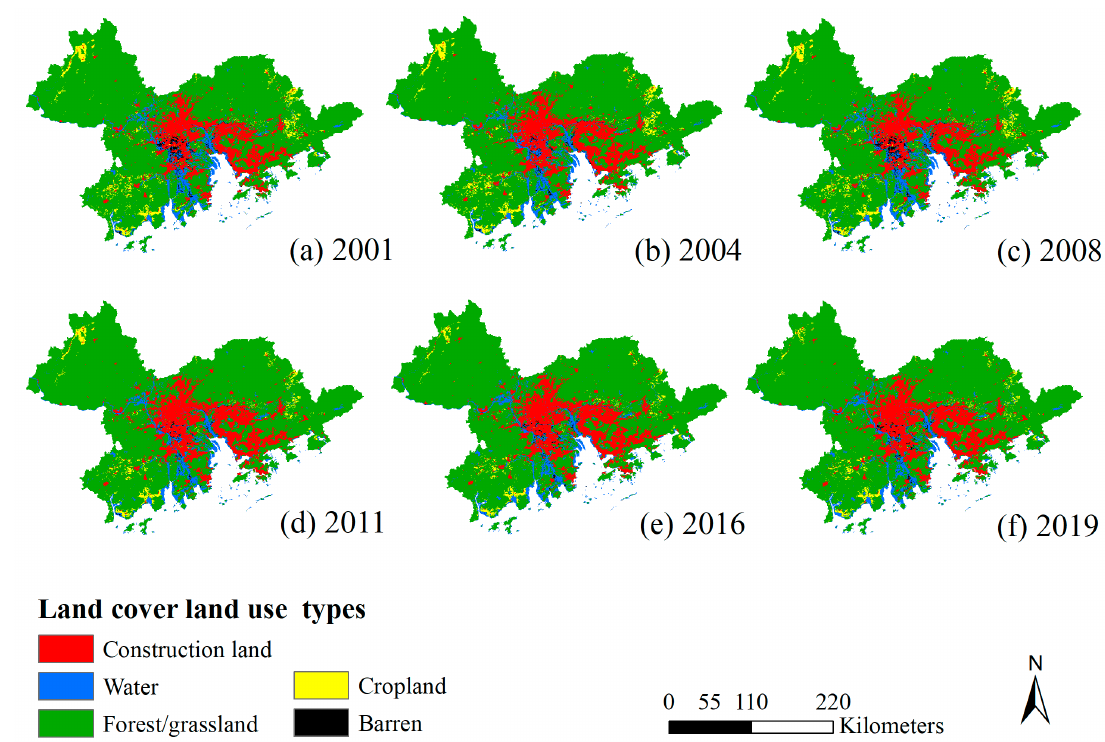
Figure 4. The spatial distribution of land cover land use in the GBA in 2001, 2004, 2008, 2011, 2016 and 2019.